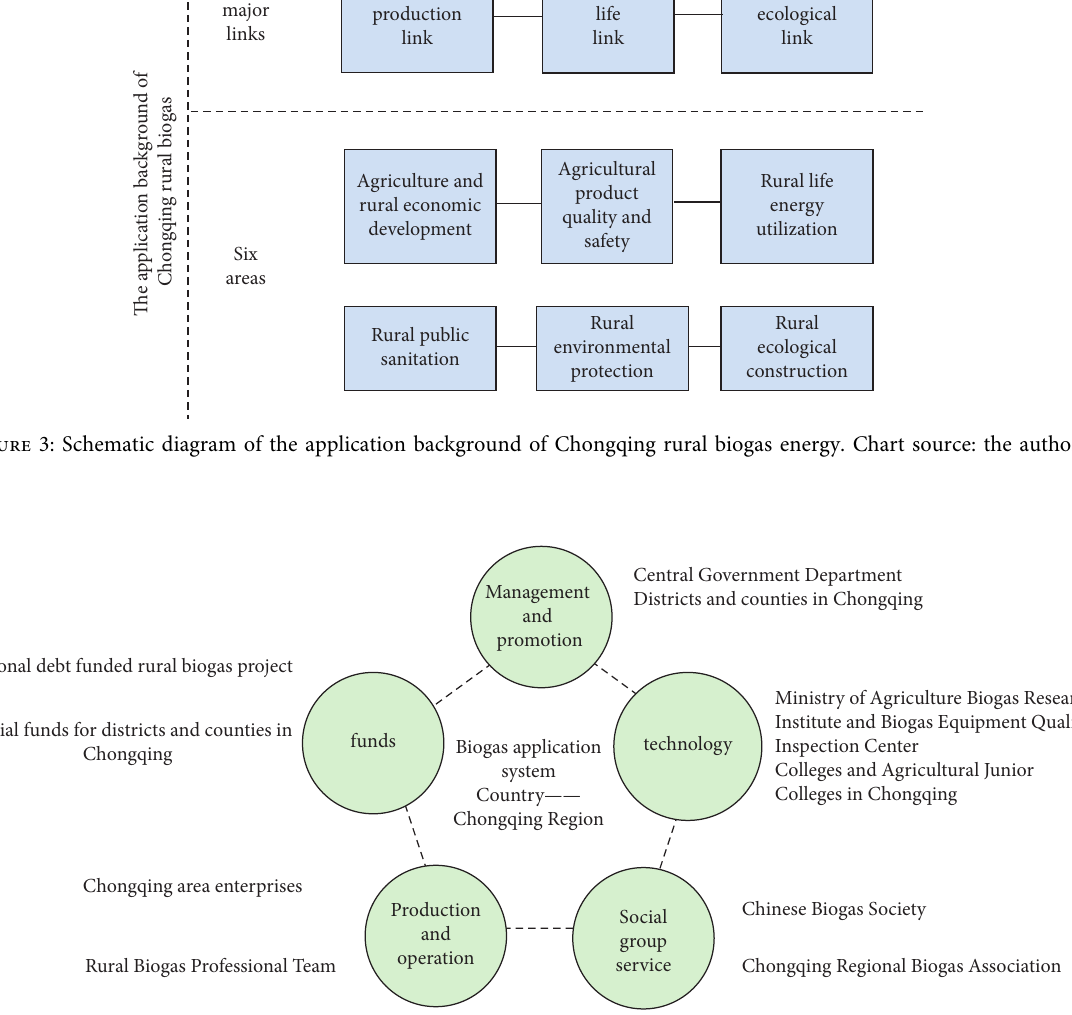
Figure 4: “National level-Chongqing area” rural biogas energy application system composition diagram. Chart source: the authors.